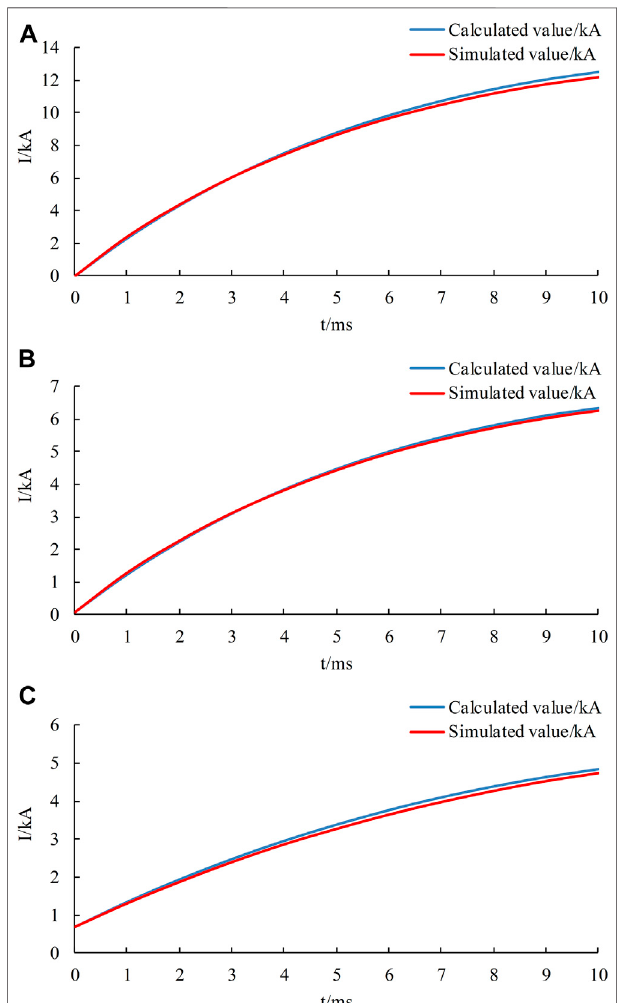
FIGURE 17 | Comparison of the calculated value and the simulated value of the fault current during a negative ground short circuit (A) Short circuit current at fault point. (B) Negative current fl owing from MMC1 to MMC2 on the fault line. (C) Negative current at the outlet of